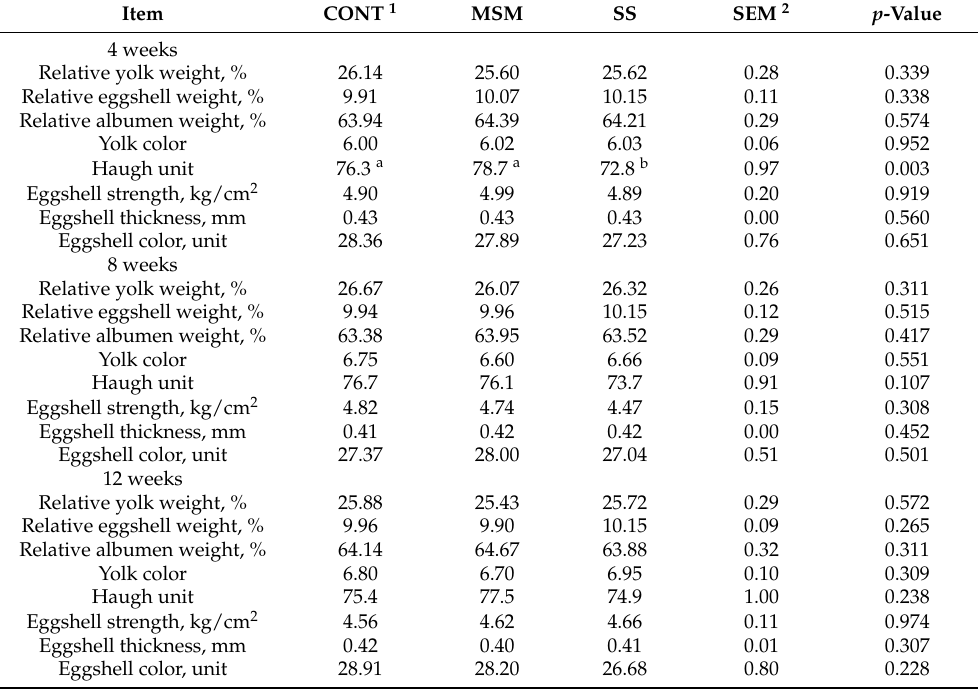
Table 4. Effects of dietary sulfur on egg composition and egg quality in laying hens ( n = 8).